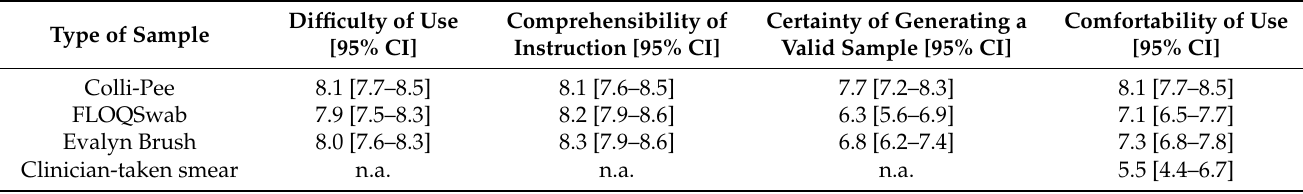
Table 5. Acceptance of self-sampling devices according to difficulty of use, comprehensibility of the instructions, certainty of generating a valid sample and comfortability of use ranging from 1 (worst possible score) to 10 (best possible score). Type of